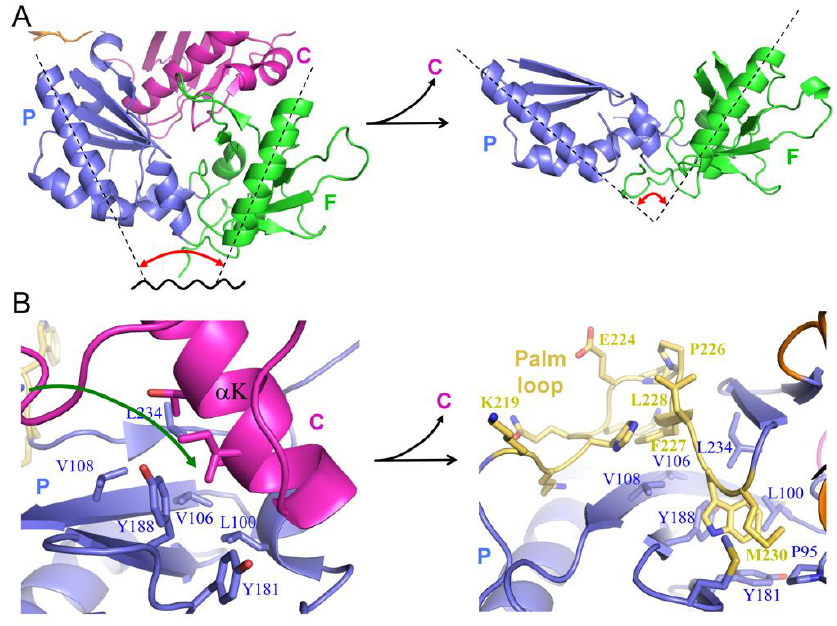
Figure 5. Structural changes of fingers/palm (F/P) that follow fingers/palm:connection dissociation. ( A ) Dissociation of the monomer fingers/palm:connection interface (PDB ID: 4KSE) leads to an expansion in the fingers/palm angle for the isolated fingers/palm domain (PDB ID: 1HAR); ( B ) Dissociation of the fingers/palm:connection interface in the monomer gives the palm loop access to the inner face of the palm domain, where it interacts with the same surface that forms the palm:connection interface (PDB ID: 1DLO). Domain color coding as in Figure 2.